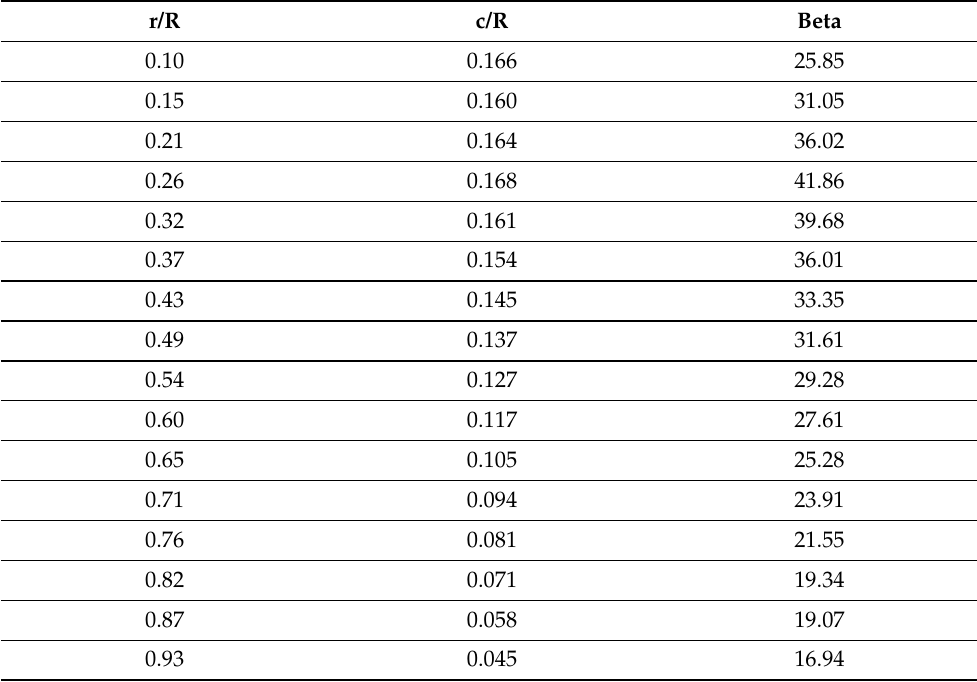
Table A5. APC 18 × 14 propeller